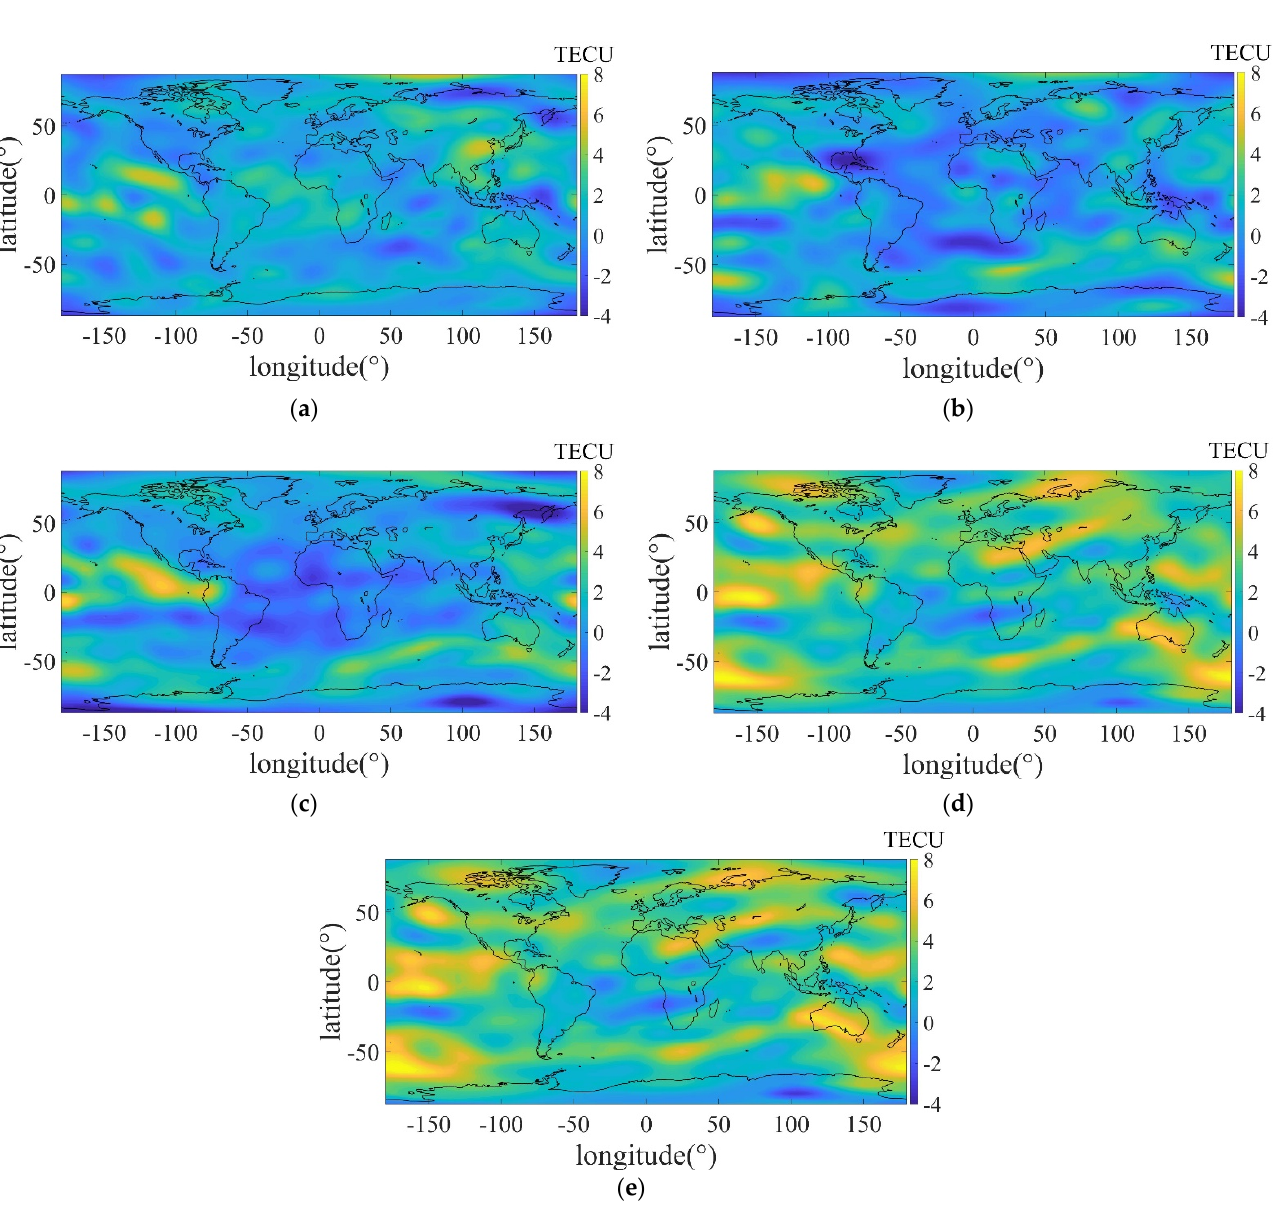
Figure 5. Biases between different results and CODE GIM at UT 0:00 DOY 213 in 2021: ( a ) GPS; ( b ) GLONASS; ( c ) Galileo; ( d ) BDS; ( e ) BDS (MEO + IGSO).